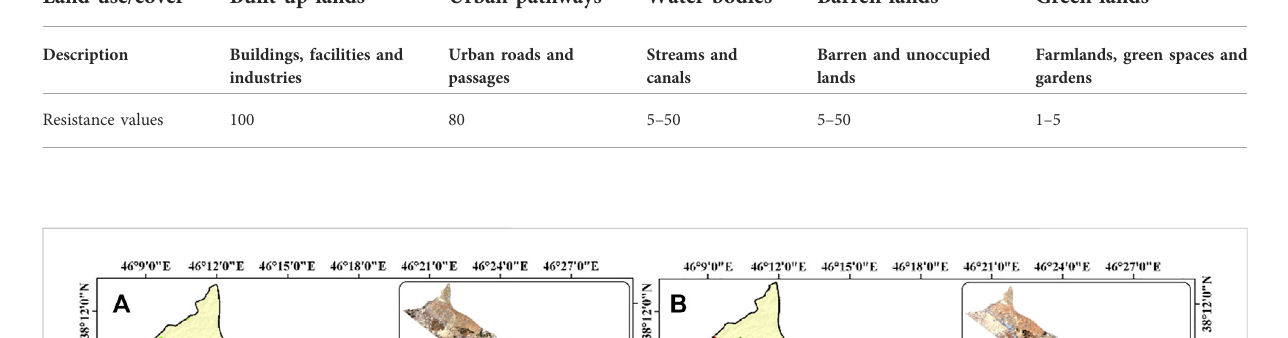
FIGURE 3 Land use map of Tabriz metropolis for 1984 (A) , 2000 (B) and 2020 (C) ; and change detection map from 1984 to 2020 (D) .